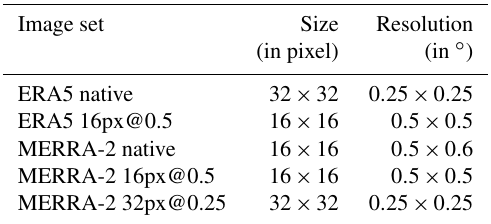
Table 5. Properties of the image sets. MERRA-2 native is used to construct the other two MERRA-2 image sets but is not used as input to the